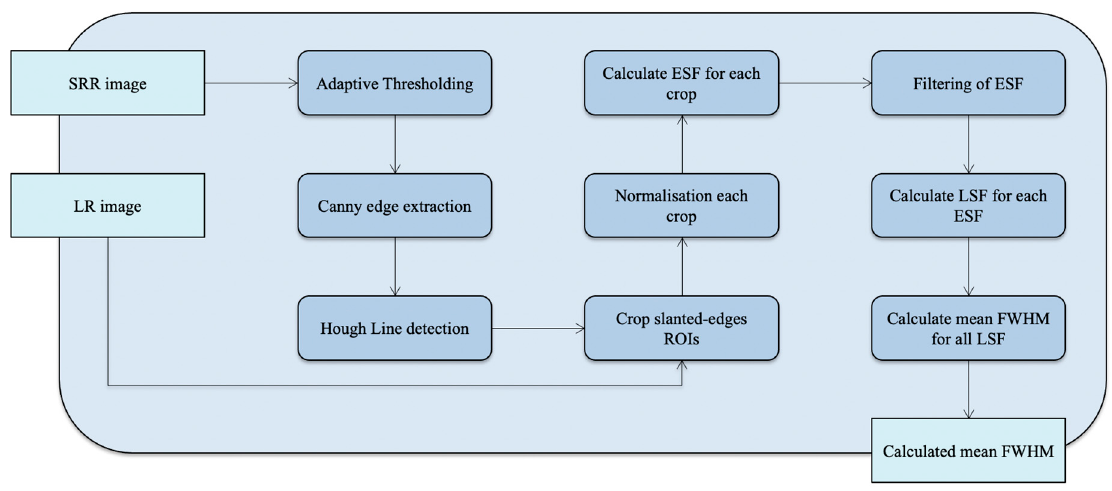
Figure 4. Flow diagram of the proposed ELF automated image effective resolution assessment system.